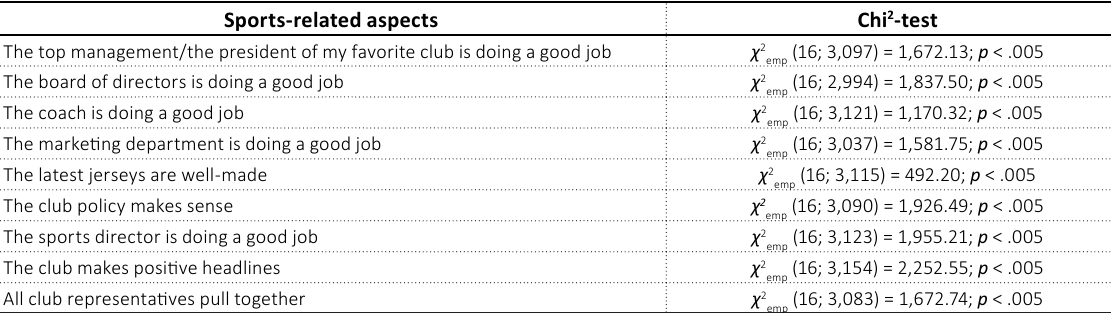
Table 4. Results of Chi 2 -tests concerning sports-related aspects Sports-related